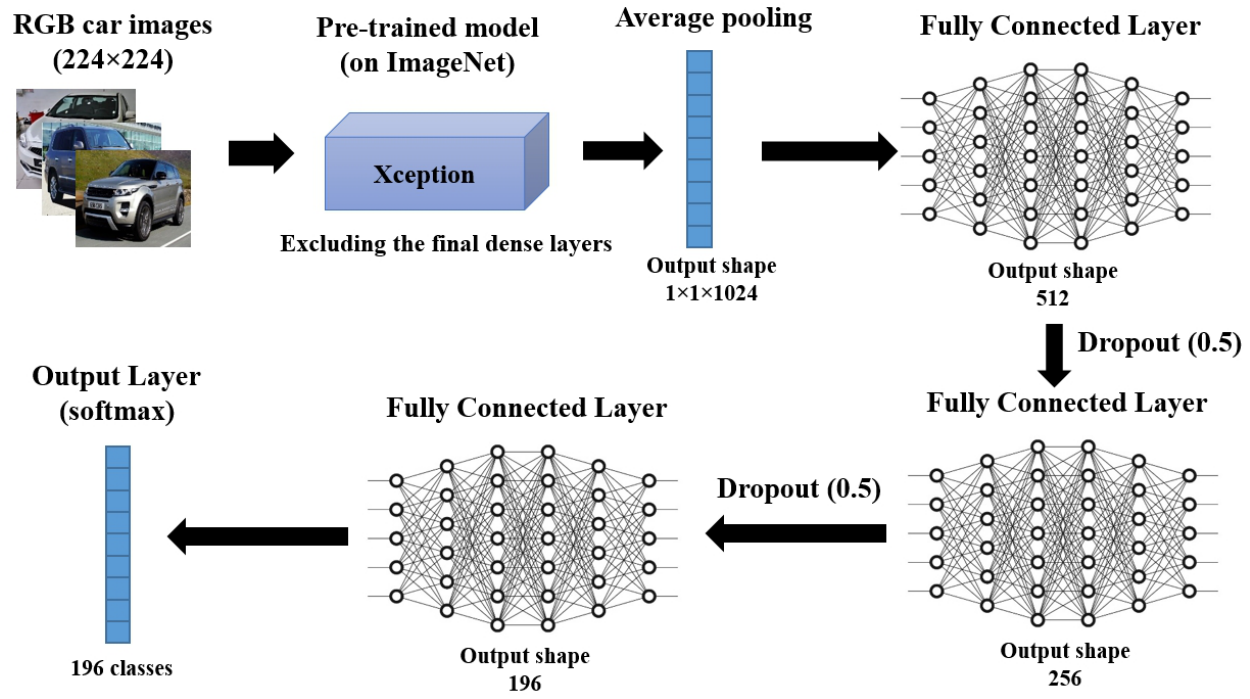
Figure 2. Architecture of the custom network used for car model